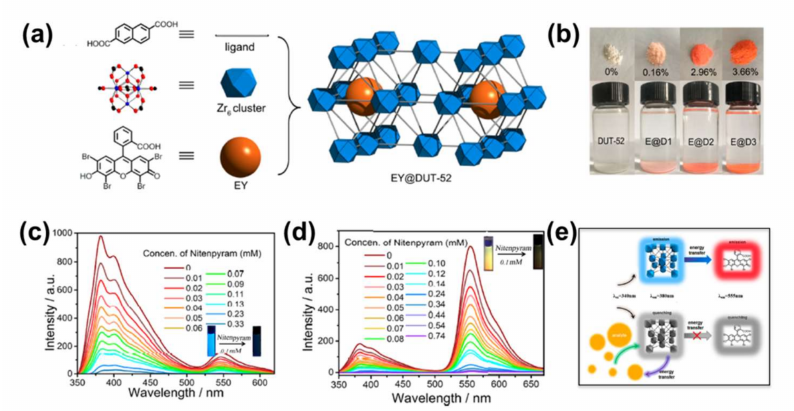
Figure 17. ( a ) Structure diagram of the as-prepared EY@DUT-52 sample. ( b ) Optical pictures of DUT-52 and three EY@DUT-52 samples under sunlight (the solvent in the vial is ethanol). ( c ) Fluo- rescent emission spectra of E@D1/ethanol suspensions with different concentrations of nitenpyram. ( d ) Fluorescent emission spectra of E@D3/ethanol suspensions with different concentrations of nitenpyram. Adapted from